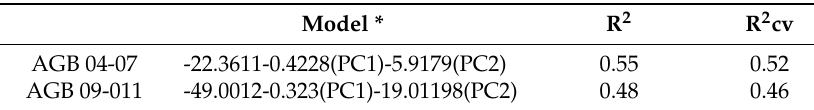
Table 5. Model selection for AGB estimation.